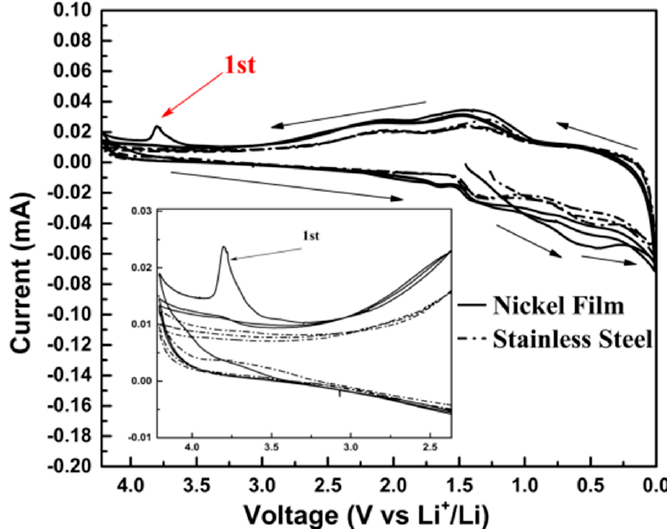
Figure 8. Cyclic Voltammogram (CV) characterization of nickel and stainless steel inside lithium ion batteries. Lithium metal is used as counter electrode.